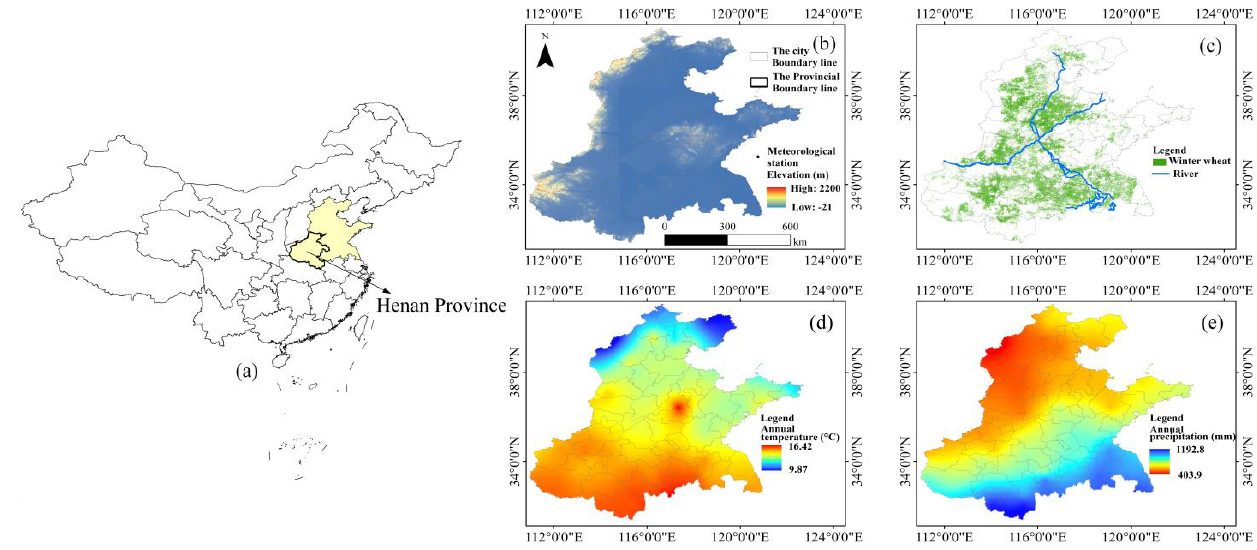
Figure 1. ( a ) Study area. ( b ) Distribution of meteorological stations. ( c ) Winter wheat planting areas and rivers. ( d ) Average daily temperature. ( e ) Average annual precipitation.